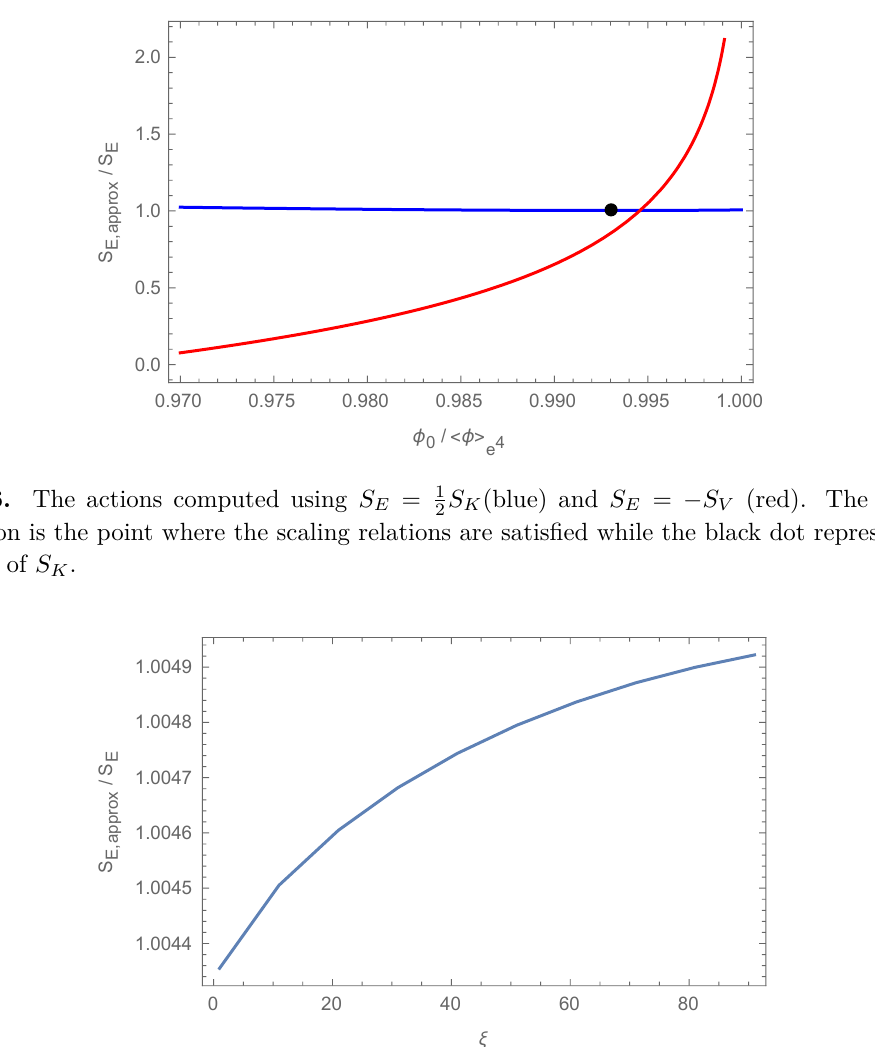
Figure 7. This shows the approximate effective action as a function of ξ using the tunneling potential approach as defined in eqs. (5.1) and (5.3). These are normalized using the corresponding values found using the bounce solution in section